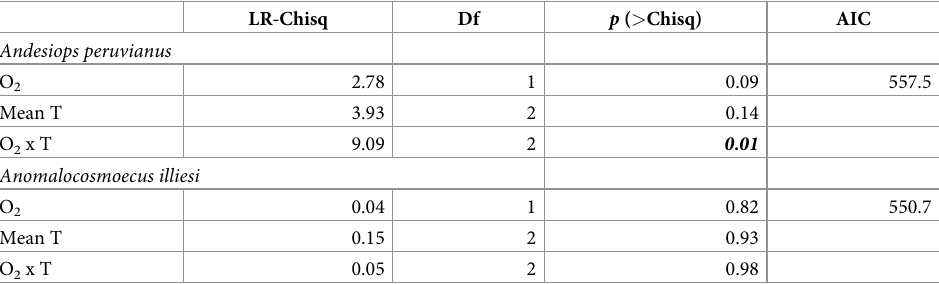
Table 3. Analysis of deviance of the GLM with a binomial distribution (link = logit .) of larval survival (%) influ- enced by dissolved oxygen (O2) and mean temperature (T) during the mesocosm experiment. Significant terms are in bold (CI =